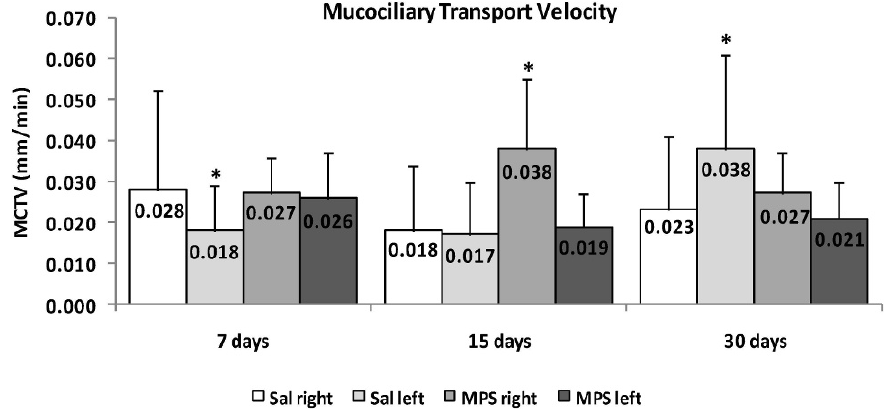
Figure 3 - Mucociliary transport velocity (MCTV) from the left (operated) or right (intact) bronchi of rats treated with saline (Sal) or mycophenolate sodium (MPS) for 7, 15, or 30 days. *Statistical differences between groups at each time point: 7 days - Sal right vs . Sal left, p= 0.034; 15 days - MPS right vs . Sal right and vs . MPS left, p= 0.014 and p , 0.001, respectively; 30 days – Sal left vs. Sal right and MPS left, p= 0.003 and p= 0.016, respectively. Behavior of groups over time: Sal left 30 days vs . 7 and 15 days, p= 0.009 and